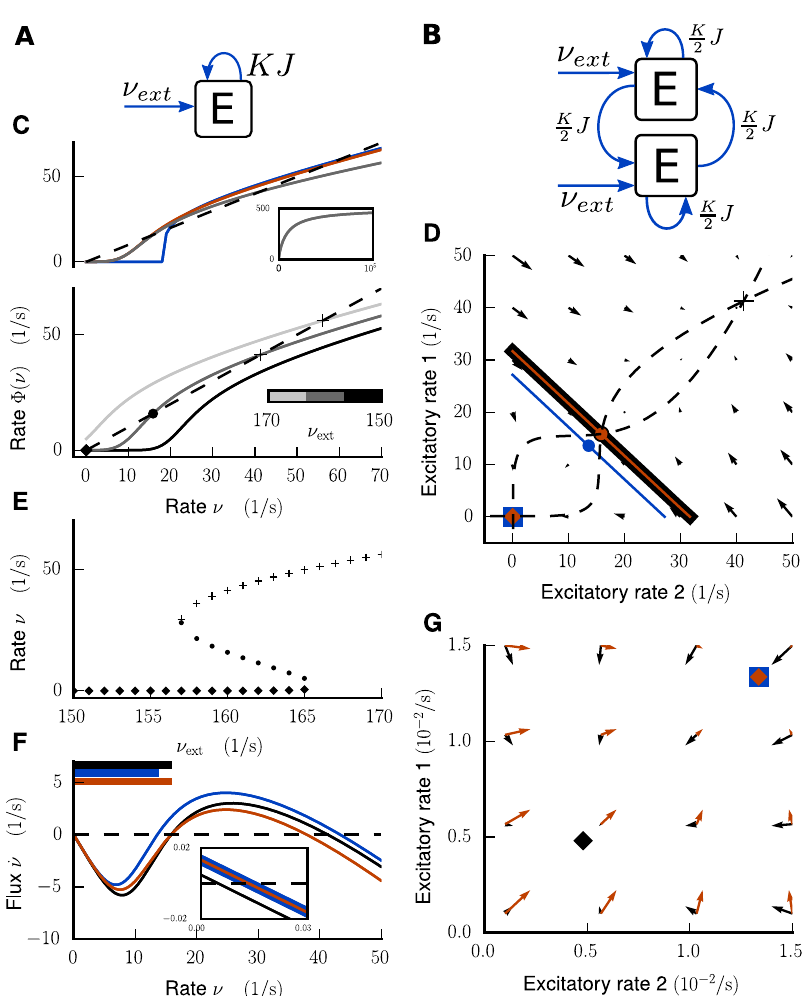
Fig 2. Activity flow in an illustrative network example. Left column: Global stability analysisin the single- Þ for population network. A Illustration of network architecture. C Upper panel: Input-output relationship F ð n ; n ext ¼ 160 1 Þ for t ¼ 0 for the noiselesscase (blue) externalPoisson drive n shown in gray. In addition F ð n ; n ext ext r s Þ for and the noisy case (red). The inset shows the gray curve over a larger input range. Lower panel: F ð n ; n ext ¼ ½ 150 ; 160 ; 170 (cid:138) 1 different rates of the externalPoisson drive n from black to light gray. Intersections with ext s the identity line (dashed)mark fixed points of the system, which are shown in E as a function of ν ext . F Flux _ n in ¼ 160 1 ; K Þ in black, F ð n 0 ¼ 161 1 ; K Þ in blue, and modifiedsystem F ð n 0 ¼ the bistablecase for F ð n ext ext ext s s ; K 0 Þ in red. Intersections with zero (dashedline) mark fixed points. The inset shows an enlargement 161 1 s close to the LA fixed point. Horizontalbars at top of figure denote the size of the basin of attraction for each of the three settings. Right column: Global stability analysisin the network of two mutually coupledexcitatory ¼ populations. B Illustration of network architecture. D Flow field and nullclines(dashedcurves) for Φ ð n ext ; K Þ and separatrices(solid lines), LA fixed point (rectangle),HA fixed point (cross) and unstable fixed 160 1 s ¼ 160 1 ; K Þ in black, Φ ð n ¼ 161 1 ; K Þ in blue, and Φ ð n ¼ 161 1 ; K 0 Þ in red. The points (circles) for Φ ð n ext ext ext s s s red separatrixand the red unstable fixed point coincidewith the black ones. G Enlargementof D close to the LA fixed points. Flow field of originalsystem shown in black, of modifiedsystem in red.